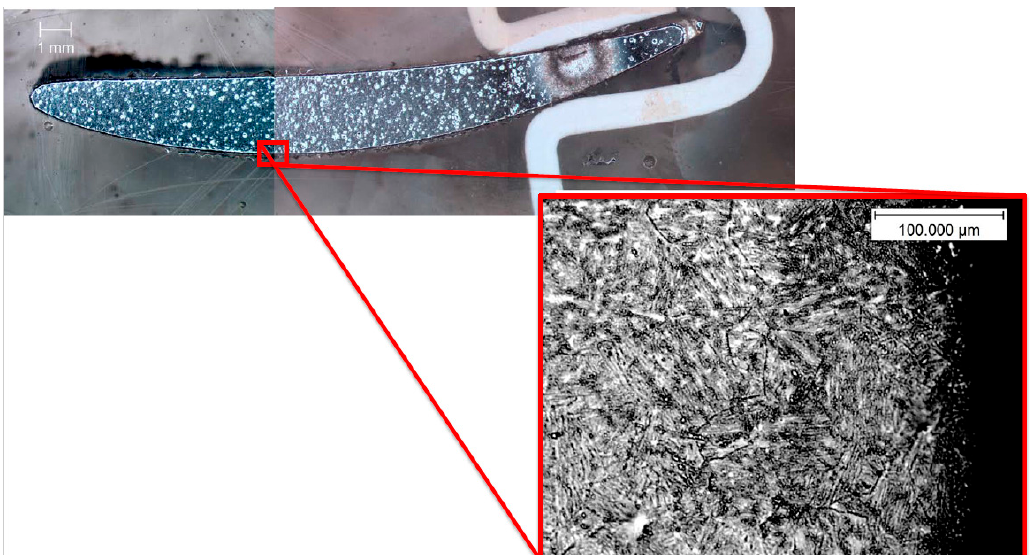
Figure 6. Picture of a cross-section of the blade with a magnified grain image from the center to the outer side of the blade.